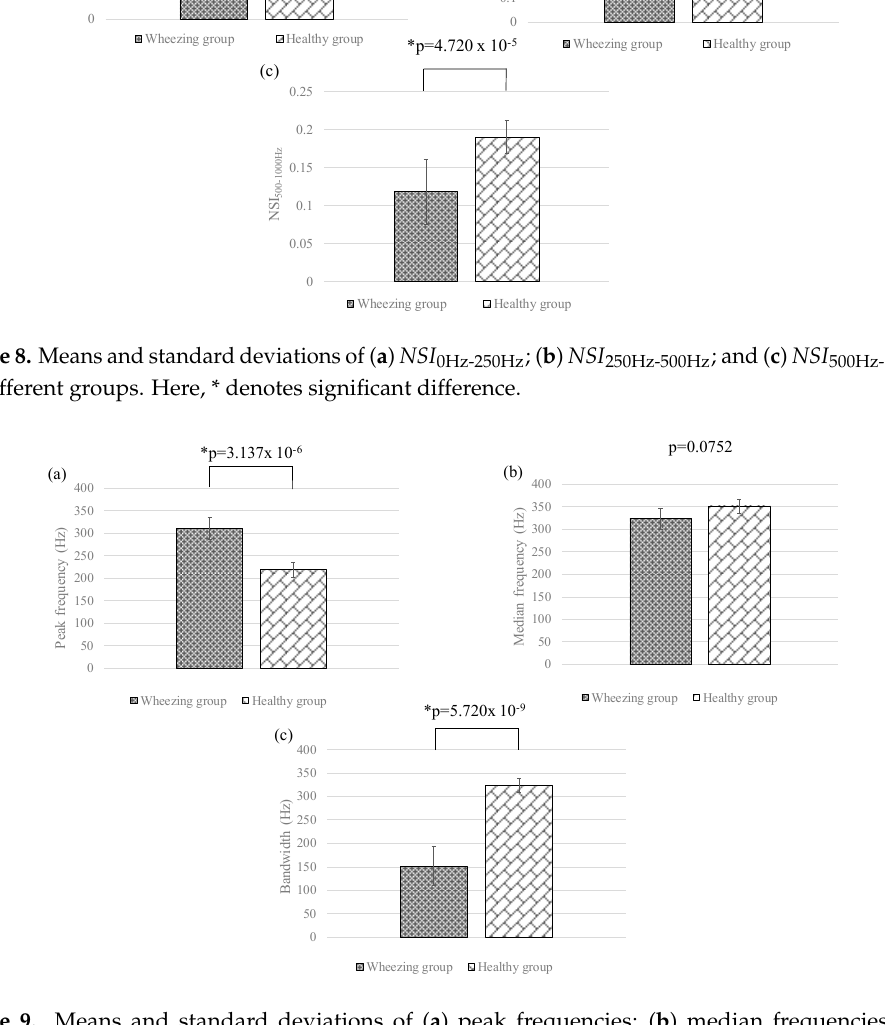
Figure 9. Means and standard deviations of ( a ) peak frequencies; ( b ) median frequencies; and ( c ) bandwidths for different groups. Here, * denotes significant difference. Table 1. Features in time and frequency domains for wheezing and healthy breathing sound groups.